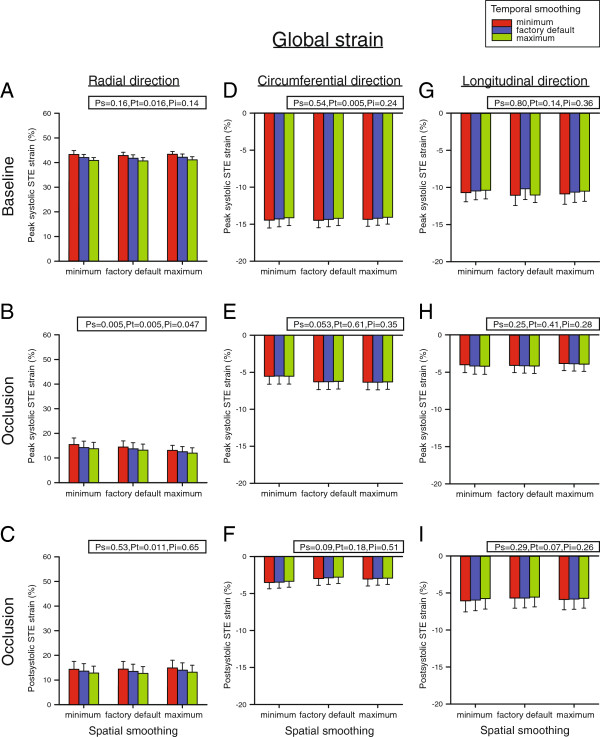
Peak- and postsystolic global strain by Speckle Tracking Echocardiography (STE) in the radial (A - C), circumferential (D - F) and longitudinal (G - I) direction at baseline and after left anterior descending coronary artery occlusion. Measurements were performed with nine different combinations of spatial and temporal smoothing created by setting these parameters in turn to minimum, factory default and maximum. Mean values of seven animals, error bars represent SEM. Ps, Pt and Pi = P-value for the effect of spatial smoothing, temporal smoothing and interaction between these two adjustments, respectively.